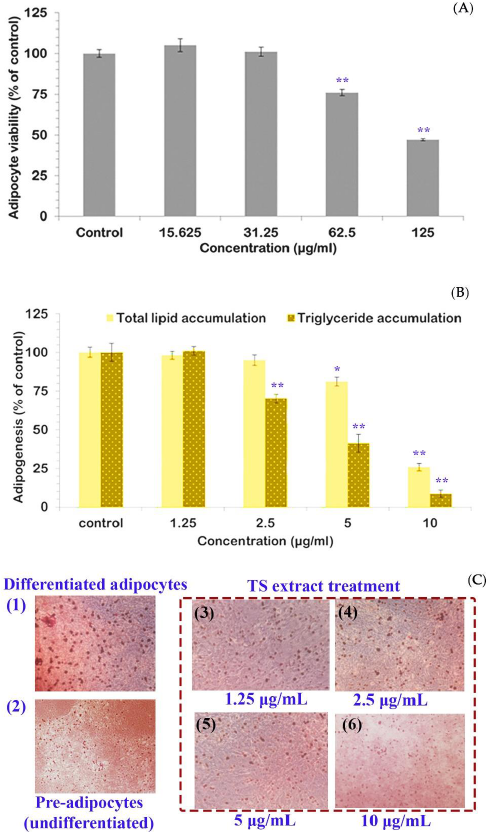
Figure 3. Tamarind seed coat (TS) extract manifested anti-adipogenesis in a dose-dependent manner. The illustrated results were achieved at a low concentration range (1.25 –10 μg/mL), given adipocyte viability >80% of control ( A ). The reduction of Oil Red O-stained cell numbers in the treatment group when the TS extract concentration increased was demonstrated under an inverted microscope (magnification 20x) ( C ) with a comparable effect to the undifferentiated group (2) at TS extract concentration of 10 μg/mL (6). In addition, reduction of lipid accumulation was manifested with statistical significance at concentrations of 5 and 10 μg/mL, compared to the control (* p -value < 0.05). Relatively, TS extract at concentrations greater than 2.5 μg/mL significantly reduced the accumulation of triglyceride when compared to the control (** p -value < 0.01) ( B ).